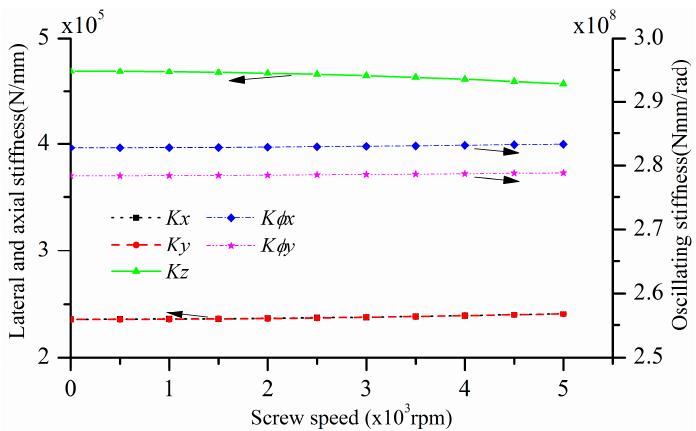
Figure 23. The global stiffness varying with different screw speed.